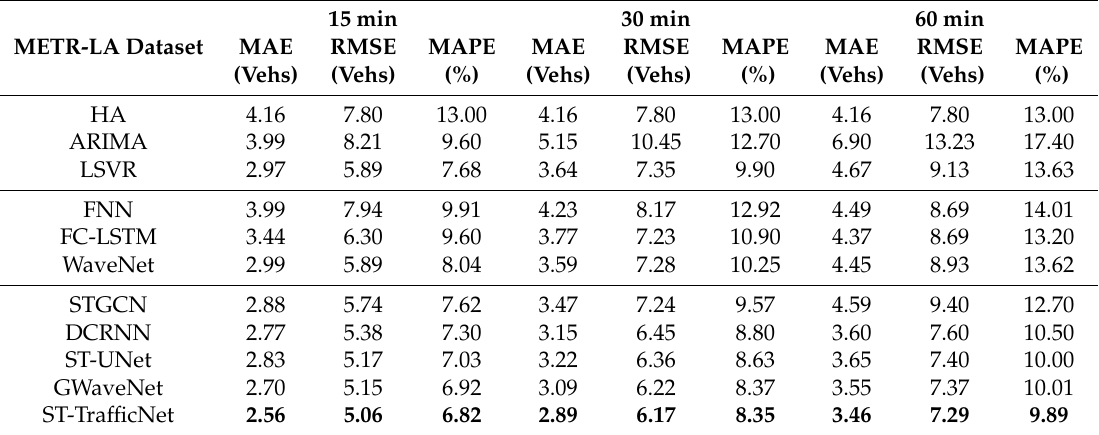
Table 1. Performance comparisons with baseline methods on METR-LA dataset. Our spatial-temporal deep learning network (ST-TrafficNet) achieves the best